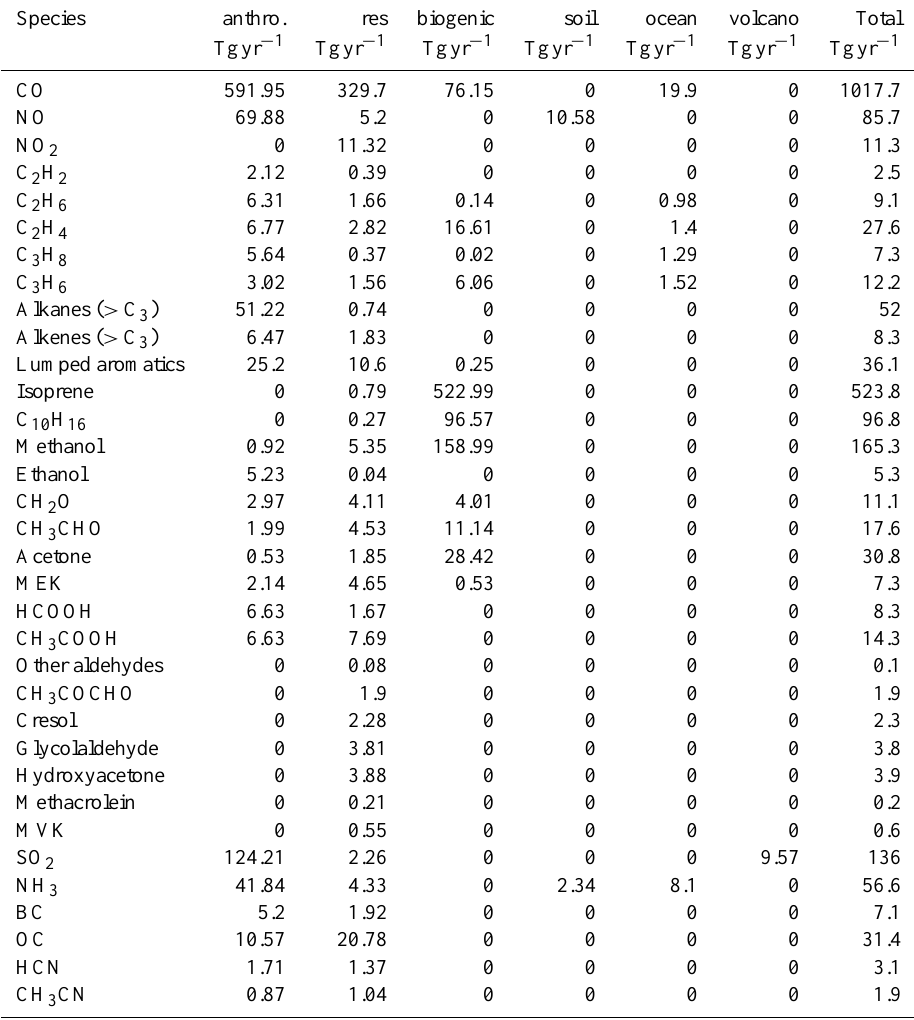
Table 1. Emissions provided for the POLARCAT model intercomparison. Species anthro. fires biogenic